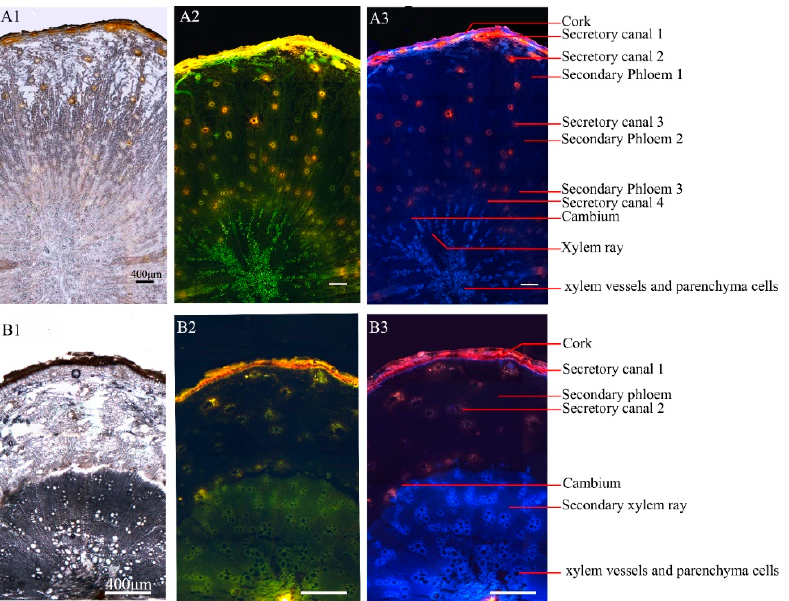
Figure 2. Microscopic characteristics of different parts of Qianhu. （ A: Sample 8; B: Sample 4 ） ( A1 ) observed under normal light mode of Ci Qianhu; ( A2 ) observed under fluorescence mode of Ci oianhu (excitation wavelength: mixed 450–490 nm and 460–500 nm); ( A3 ) observed under fluorescence mode of Ci Qianhu (equipped with triple band filter RGB); ( B1 ) observed under normal light mode of Xiong Qianhu. ( B2 ) observed under fluorescence mode of Xiong Qianhu (excitation wavelength: mixed 450–490 nm and 460–500 nm); ( B3 ) observed under fluorescence mode of Xiong Qianhu (equipped with triple band filter RGB).